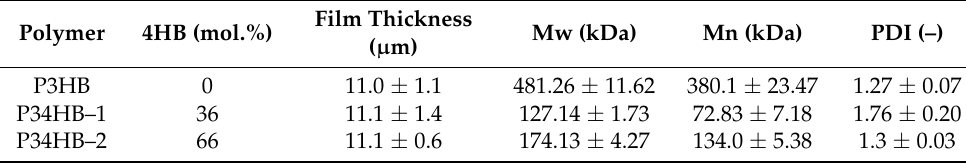
Table 1. Parameters of manufactured